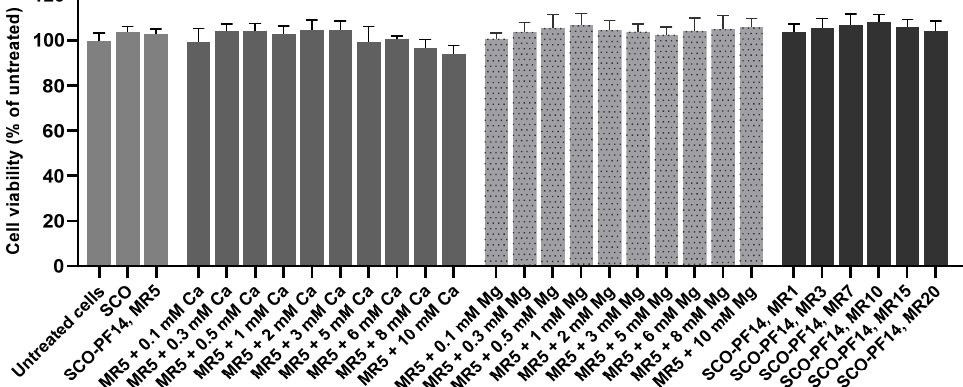
Figure 2. The effect of SCO, PF14, calcium and magnesium ions on viability of cells. HeLa pLuc 705 cells were incubated for 24 h with solutions containing SCO alone (100 nM), nanoparticles of SCO and PF14 taken at different molar ratios (MR) or calcium or magnesium-complemented nanoparticles. Viability of the cells was evaluated using WST-1 assay, and absorption of untreated cells was taken as 100%. Each dataset represents mean + SEM of at least 3 independent experiments. Data was analyzed by one-way ANOVA with Dunnett’s test, and no statistically significant differences were detected.